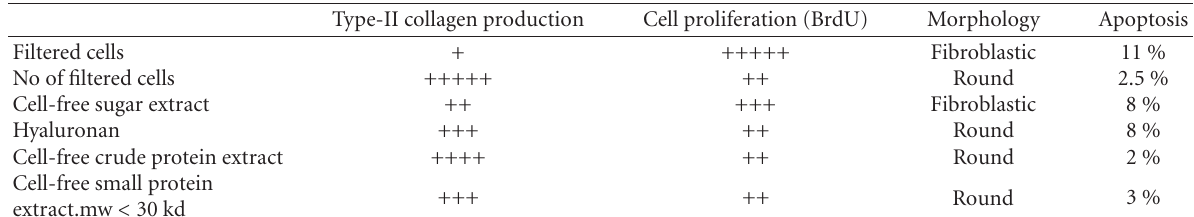
Table 1. Role of extracellular matrix components on morphology (fibroblastic and round cells), proliferation (BrdU incorporation), and redi ff erentiation (colagen II production) of auricular cultured chondrocytes. Determination of apoptosis using p53 as a biochem- ical